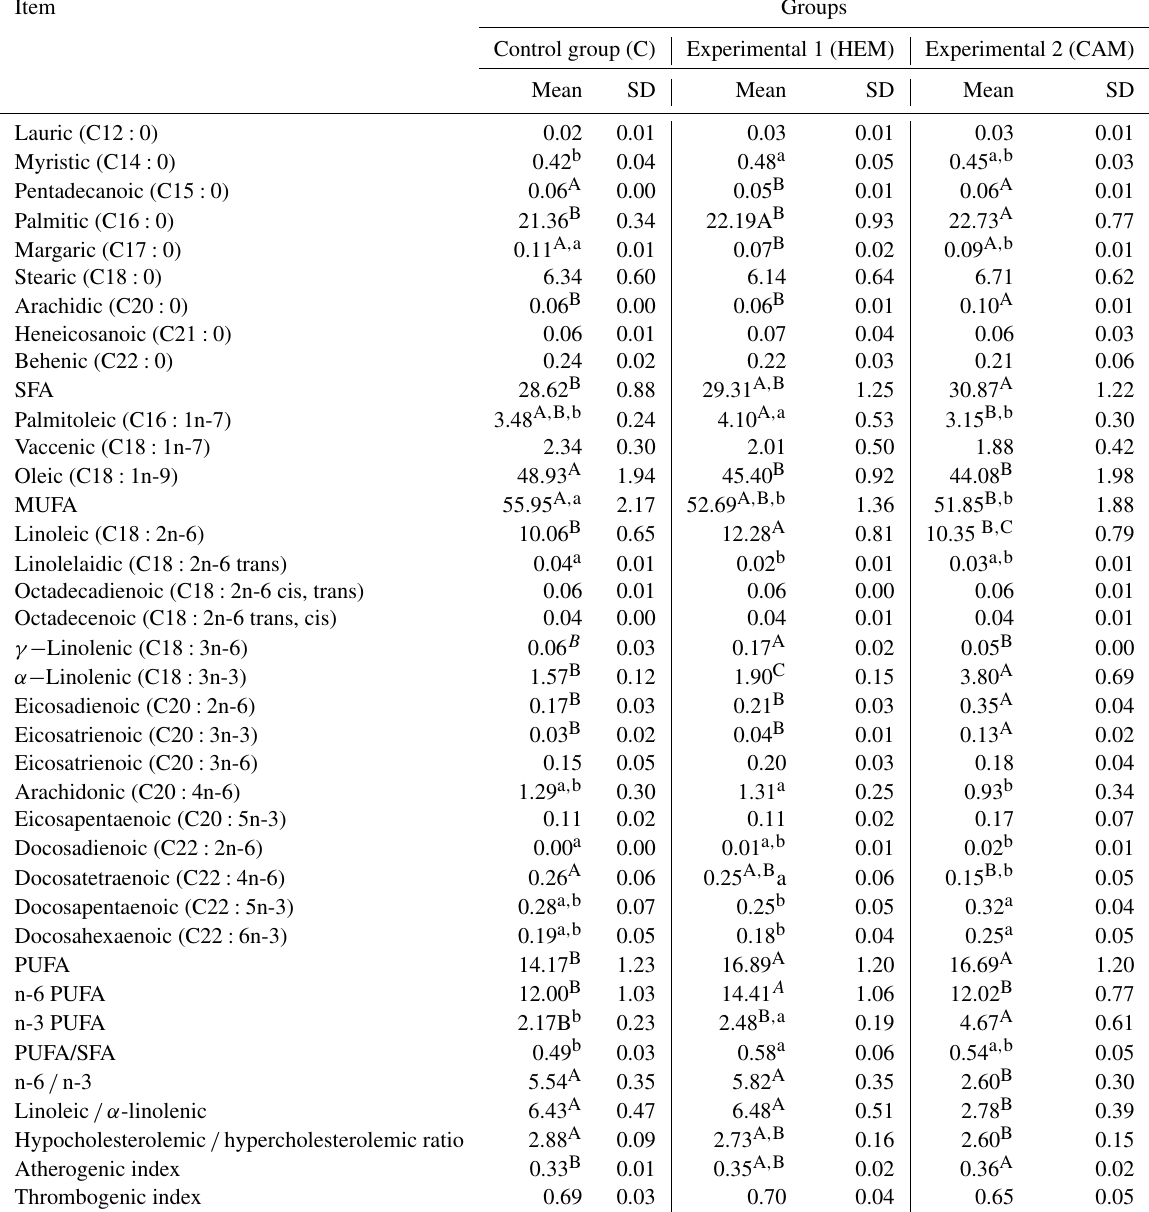
Table 4. The fatty acid composition of duck leg muscles (% of total fatty acids). Item